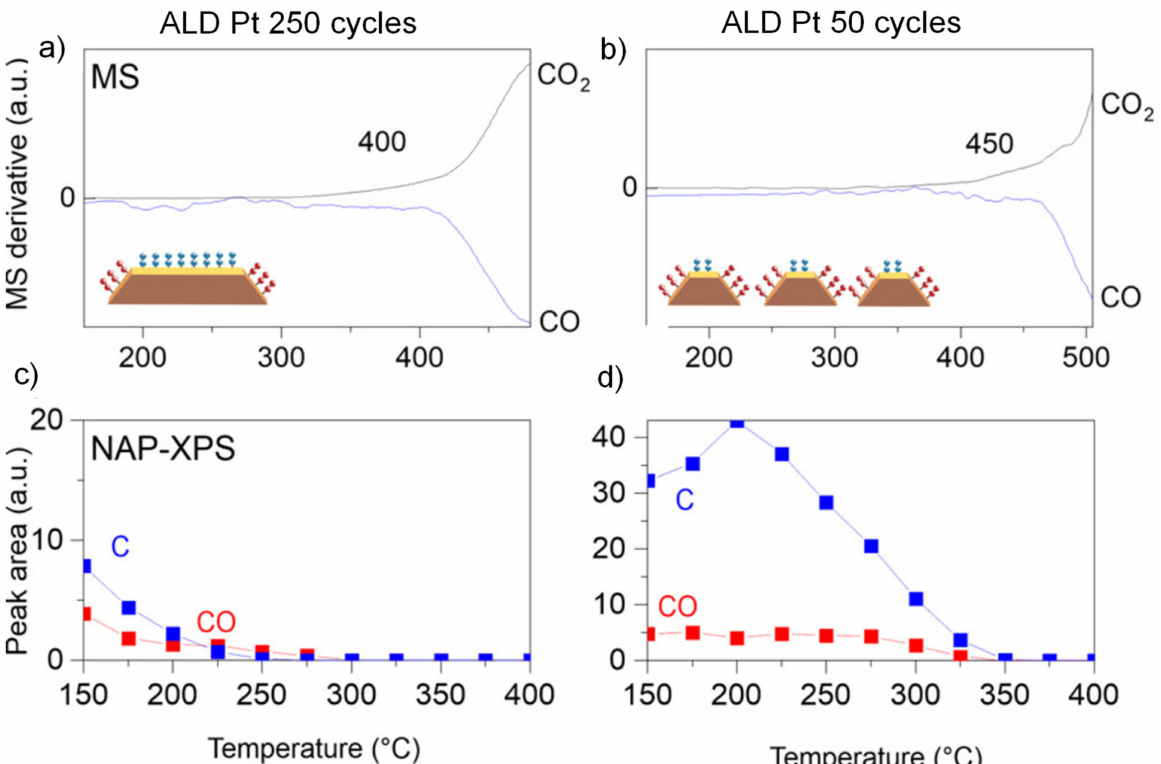
Figure 3. ( a , b ) Derivatives of the mass spectrometry data of CO and CO 2 . ( c , d ) Temperature-dependent evolution of adsorbed CO and carbon deduced from C 1s NAP-XPS (1 mbar CO, 2 mbar O 2 ; flow mode) (reproduced from Ref.